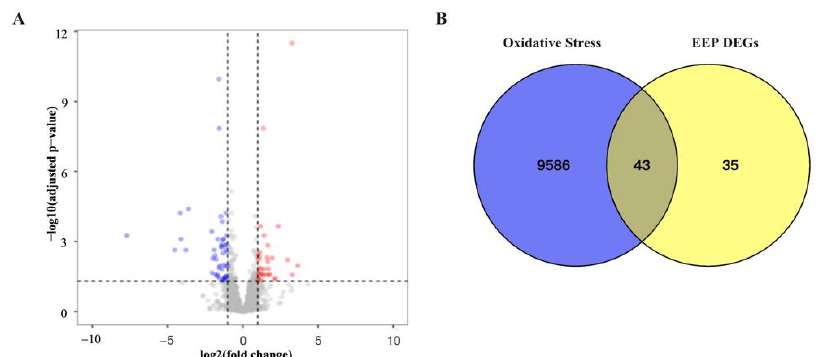
Figure 5. Identification antioxidative genes of differentially expressed genes of EEP in hyperthy- roidism mice of EEP on transcriptomics profiles. ( A ) Volcano map of significantly upregulated genes and downregulated genes in the EEP and hyperthyroidism model groups. ( B ) Venn diagram of EEP against hyperthyroidism DEGs, oxidative stress, and intersection genes.